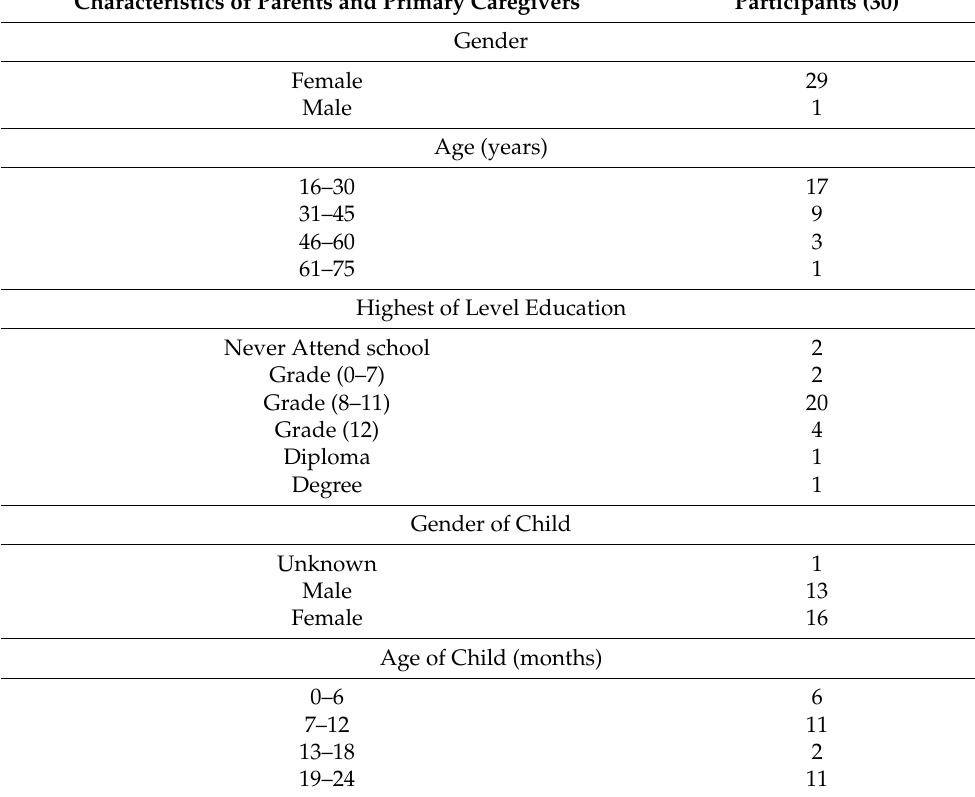
Table 1. Participant